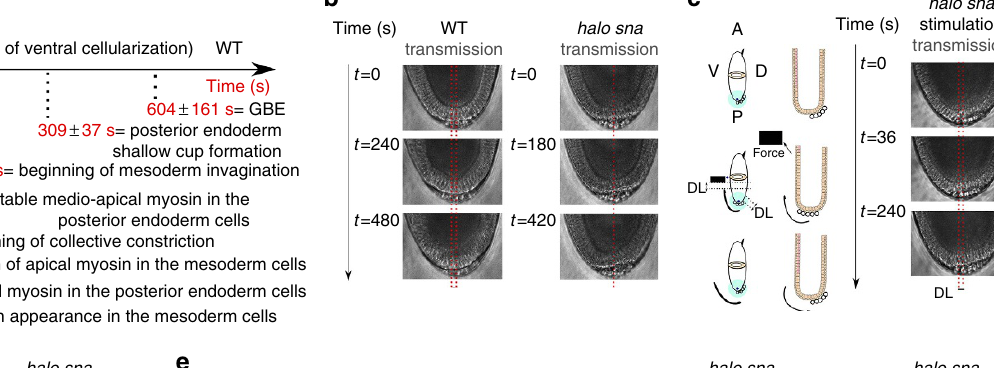
NATURE COMMUNICATIONS|8:13883|DOI: